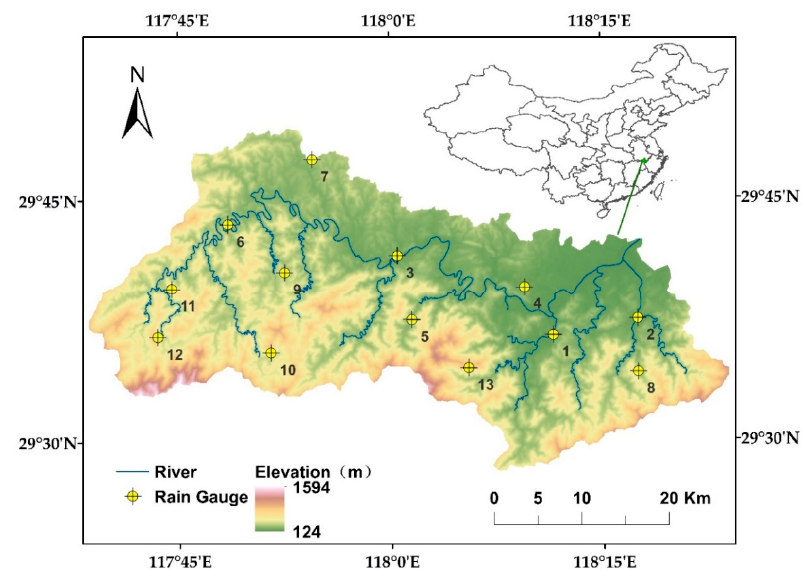
Figure 1. Map of Shuaishui River Basin.